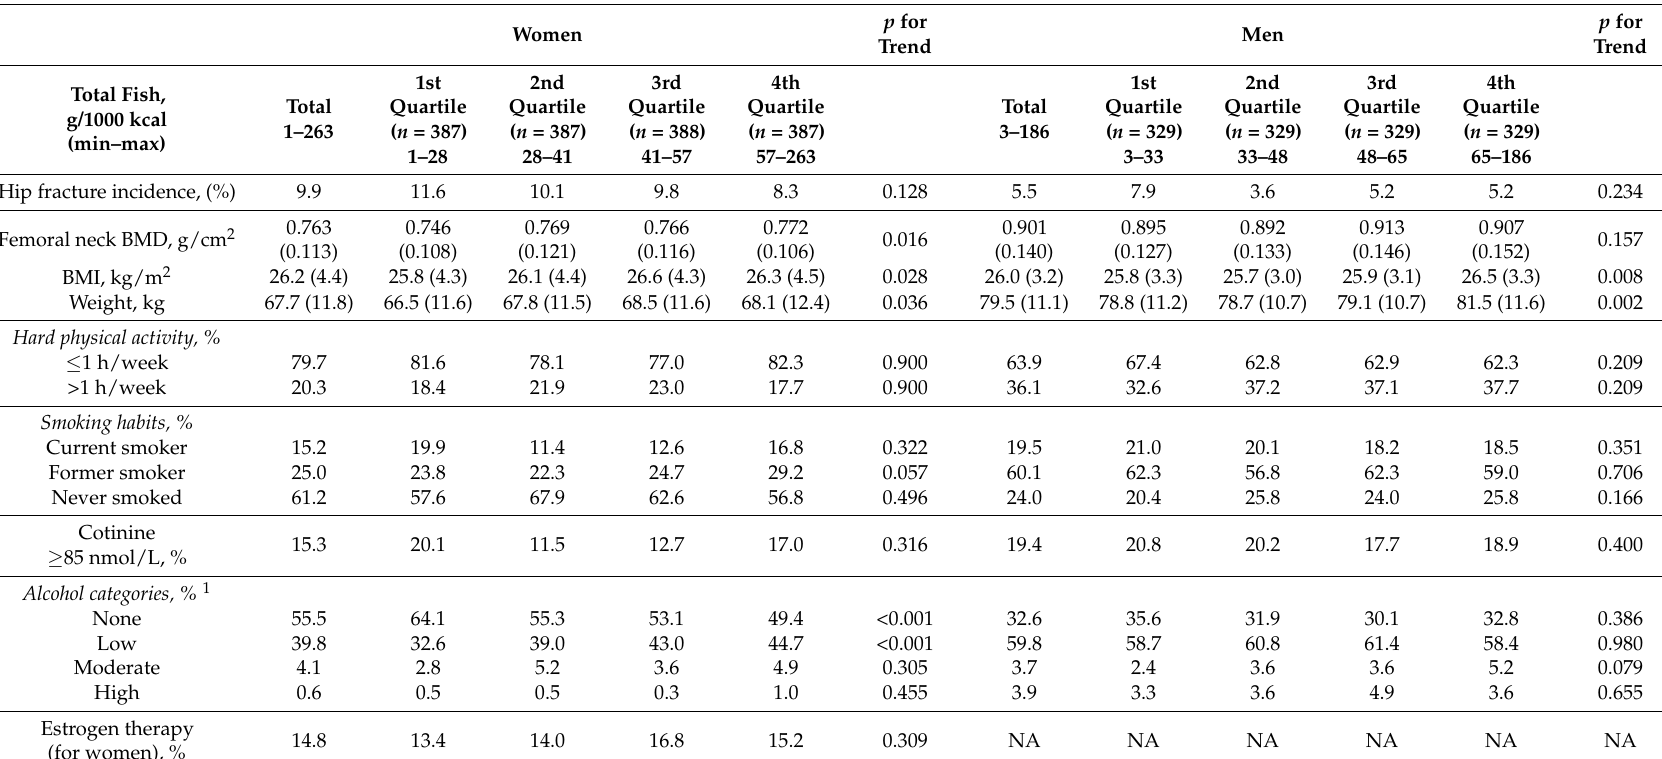
Table 1. Baseline (1997–1999) characteristics of men and women (age 71–74 years) by sex-specific quartiles of total fish intake. The Hordaland Health